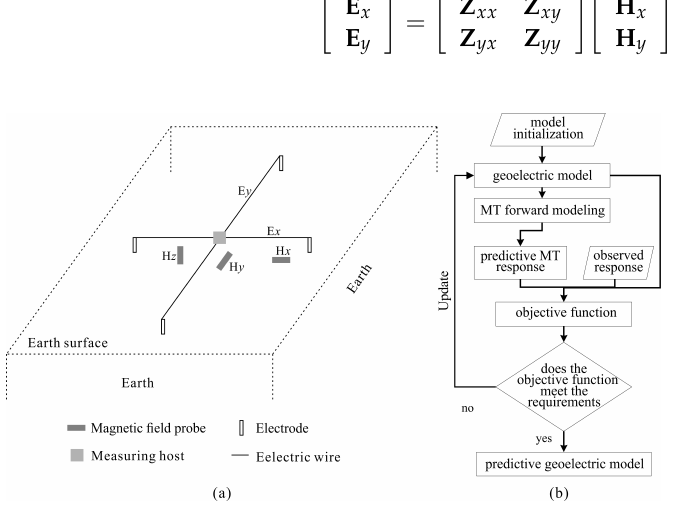
Figure 1. Basic introduction of the magnetotelluric (MT) method. ( a ) shows the layout of the MT signal acquisition system. The electrodes connected by wires is used to obtain electric field data, and the magnetic field probes are used for collecting magnetic field data. The host is used to record the signal at various frequencies. ( b ) The application of the optimization process in MT